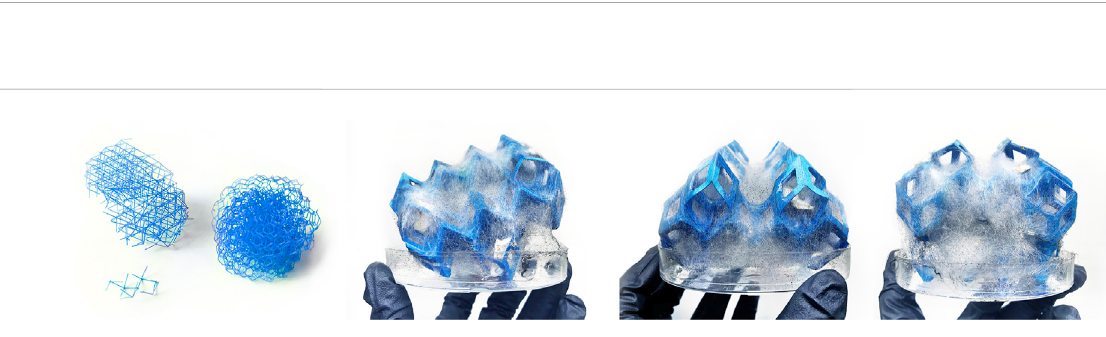
FIGURE 6 Scaffoldings.ExampleoflatticefromSolusprinteravailableinRothschild ’ slab,myceliumgrowingonpaper-basedorigamiscaffold coatedwith nutrients and agar.